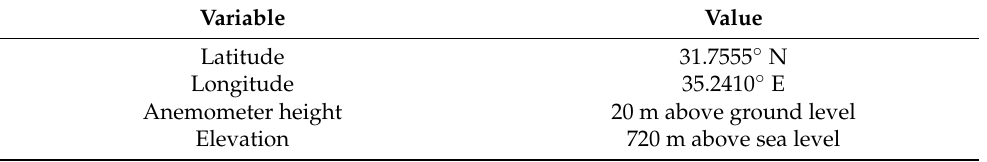
Table 1. Geographical coordinates of the metrological station in East